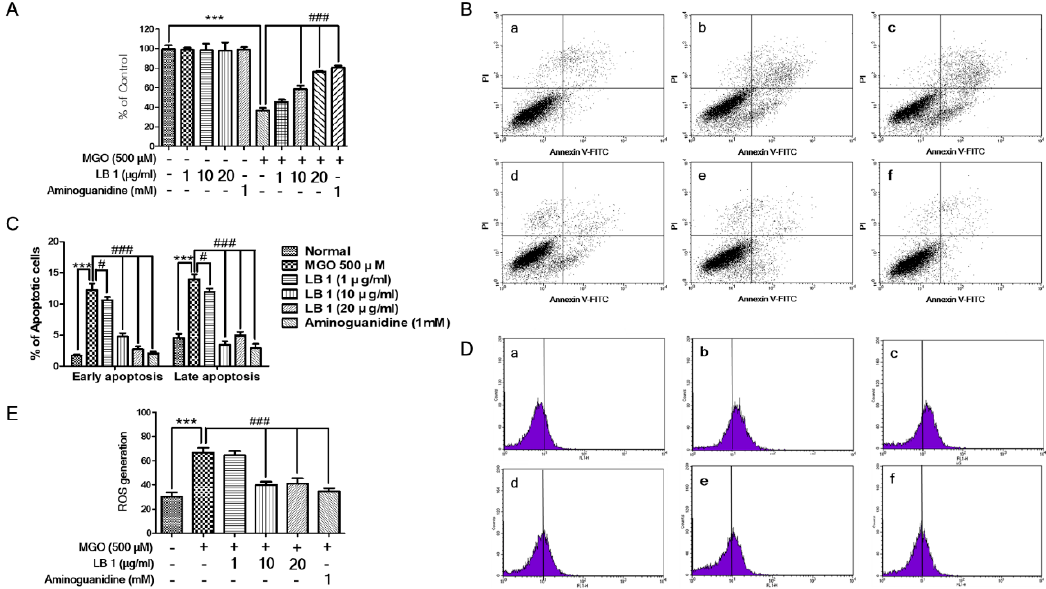
Figure 1. The effect of LB on reduced cell viability and increased apoptosis and oxidative stress induced by MGO in LLC-PK1 cells. ( A ) Viability of LB and MGO-treated LLC-PK1 cells was analyzed with MTT assay. ( B ) Effect of LB on MGO-induced apoptosis of LLC-PK1 cells. Flow cytometry analysis in MGO-stimulated LLC-PK1 cells performed with annexin V-FITC and PI staining: a , control; b , cells treated with 500 µM MGO; c , cells treated with MGO + LB (1 µg/mL); d , cells treated with MGO + LB (10 µg/mL); e , cells treated with MGO + LB (20 µg/mL); and f , cells treated with MGO + aminoguanidine (1 mM) as the positive control. ( C ) Effect of LB on early and late apoptosis was analyzed by flow cytometry. ( D ) The results of flow cytometry performed with DCF-DA staining of MGO-stimulated LLC-PK1 cells: a , control; b , cells treated with 500 µM MGO; c , cells treated with MGO + LB (1 µg/mL); d , cells treated with MGO + LB (10 µg/mL); e , cells treated with MGO + LB (20 µg/mL); and f , cells treated with MGO + aminoguanidine as the positive control. ( E ) Effect of LB on the generation of ROS was analyzed by flow cytometry. The values are represented as the mean ± SEM (## p < 0.01 and ### p < 0.001 vs. MGO treatment, and ** p < 0.01 vs. the control).